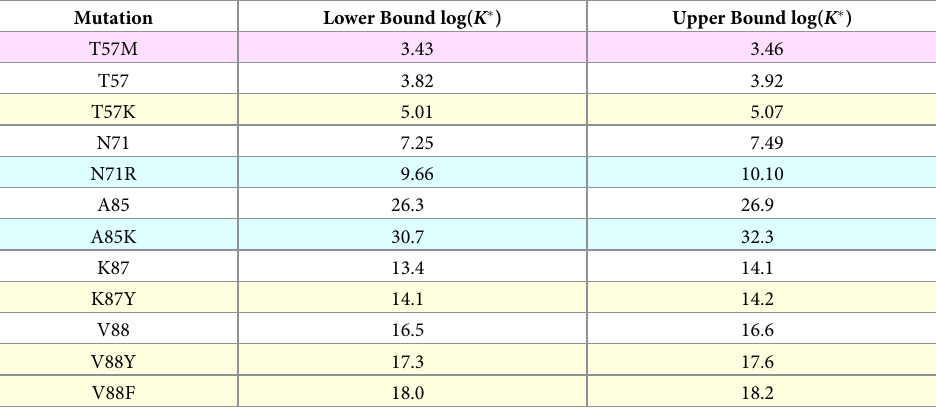
Table 1. Computational predictions by OSPREY / FRIES / EWAK � that were selected for experimental validation. Each row of the table shows the results of the redesign of a residue position in c-Raf-RBD in the c-Raf-RBD:KRas PPI that were also selected for experimental validation (all of the computational results are listed in S3 Table). The table contains the values for upper and lower bounds on log( K � ) values (the calculation of these bounds is described in detail in [32]). Mutations highlighted in yellow, blue, and pink were selected for experimental testing and validation. The two residues highlighted in blue are the best previously discovered [60] mutations that improve binding (independently and addi- tively) and are included in our tightest binding variant, c-Raf-RBD(RKY) (Figs 8, 9 and 10). The variants highlighted in yellow are, to the best of our knowledge, never-before-tested variants that are predicted to increase the binding of c- Raf-RBD to KRas GTP . The variant highlighted in pink was selected for experimental testing to act as a mutation pre- dicted to be comparable to wild-type to test how accurately OSPREY predicted the effects of these